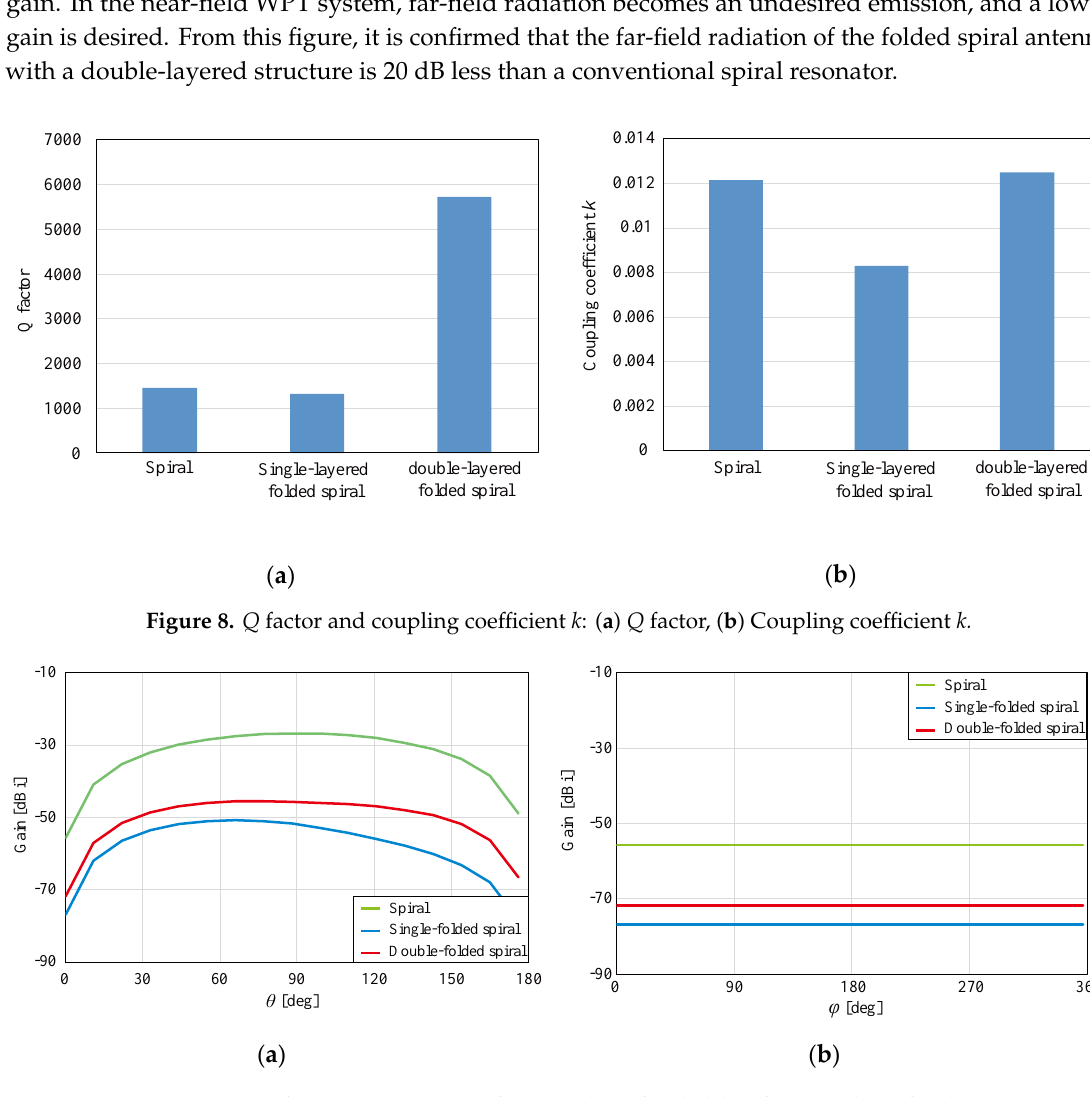
Figure 9. Radiation pattern: ( a ) θ direction (z-x plane), ( b ) φ direction (x-y plane).